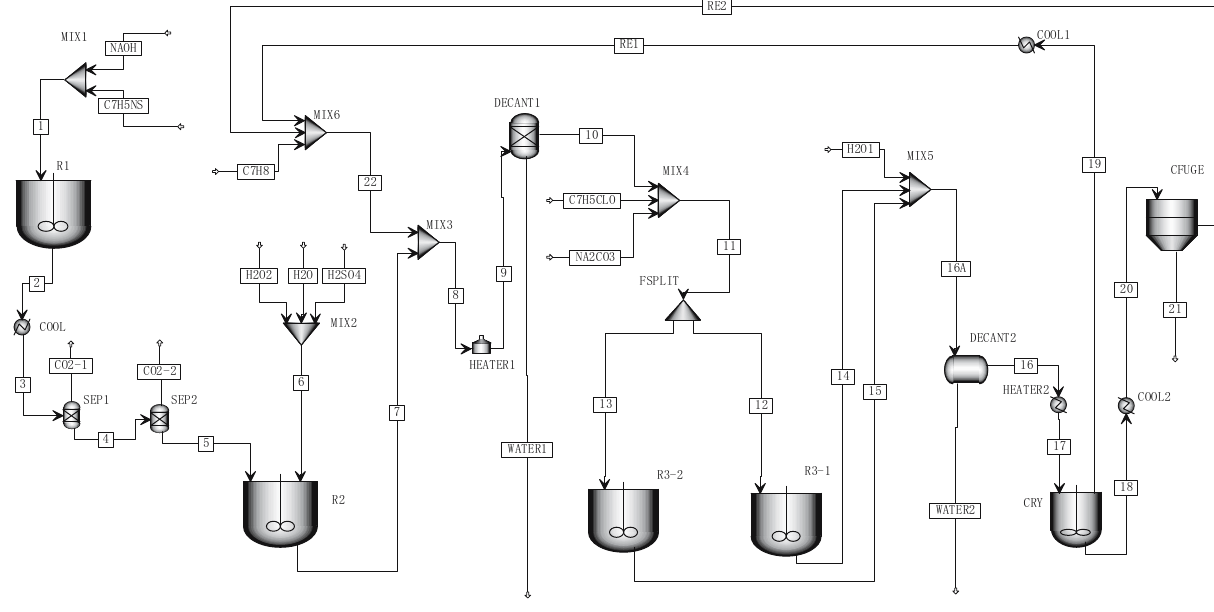
Figure 3: The process fl owchart for DBD production in Aspen Plus.